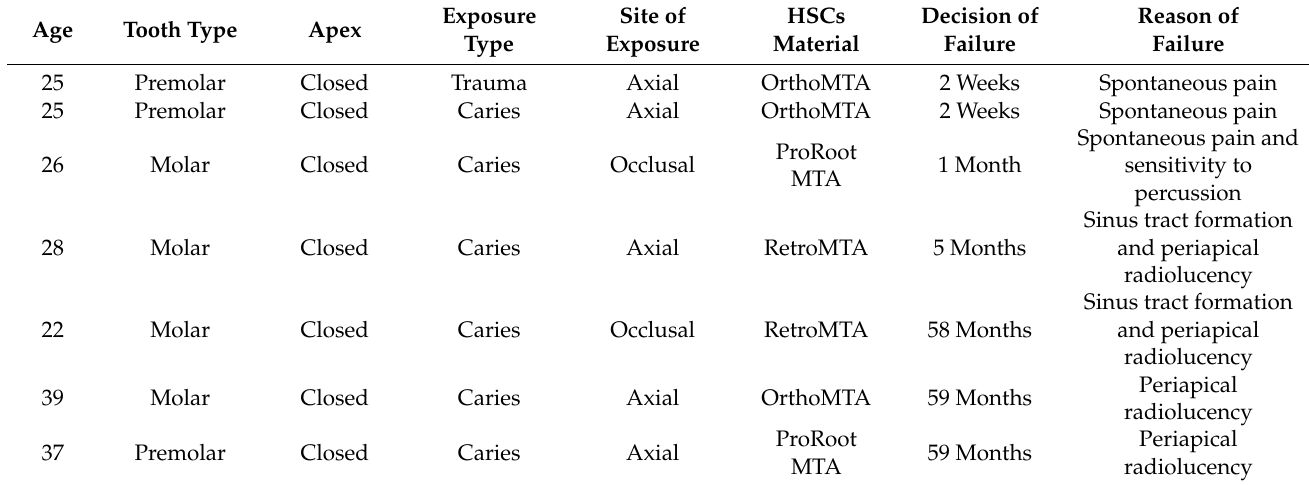
Table 4. Characteristics of total failed cases in follow-up of partial pulpotomy with